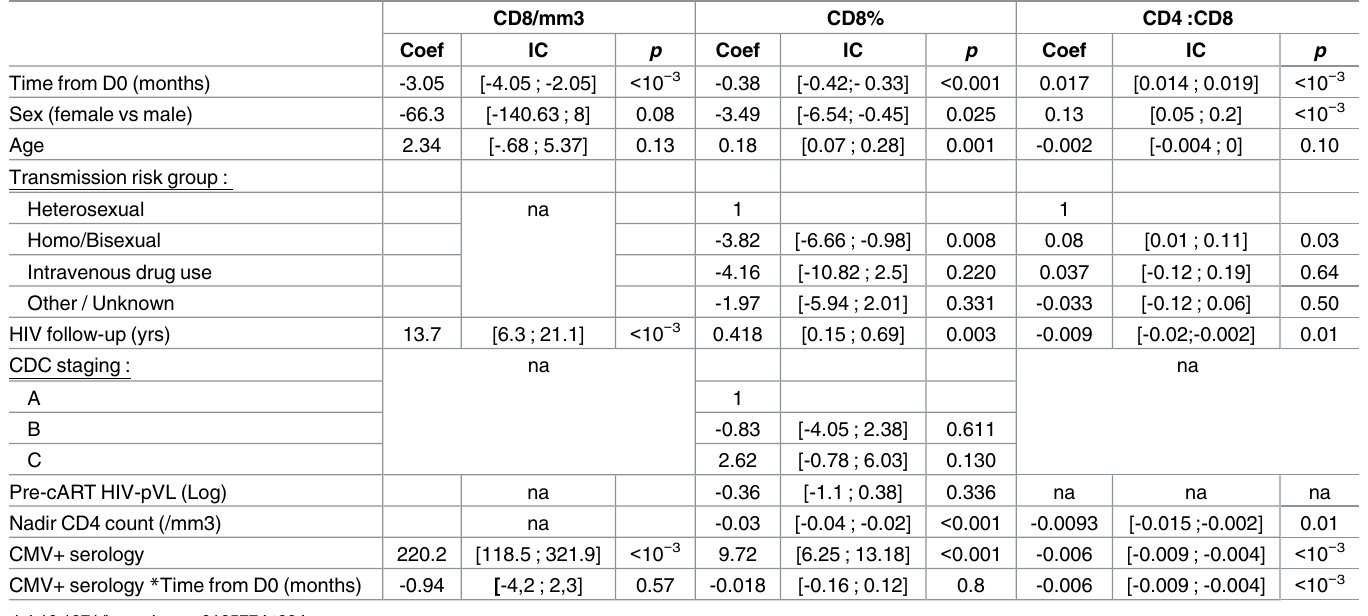
Table 4. Multivariate linear-mixed model analyses of factors associated with CD8+ T cell counts, CD8% and CD4:CD8